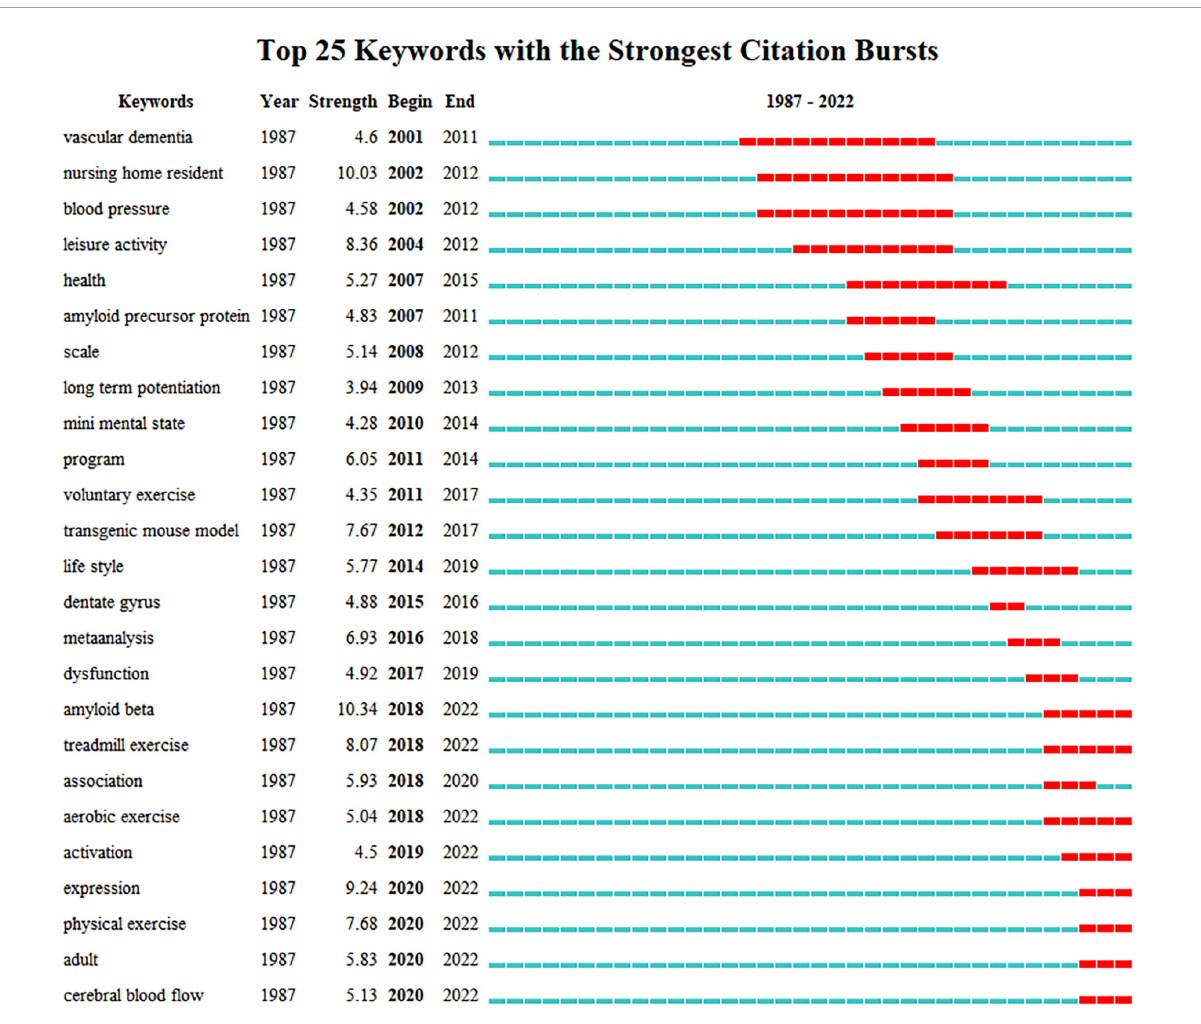
FIGURE7 The keywords with the strongest citation bursts of publications. Each blue or red short line represents a year, and a red line stands for a burst detected